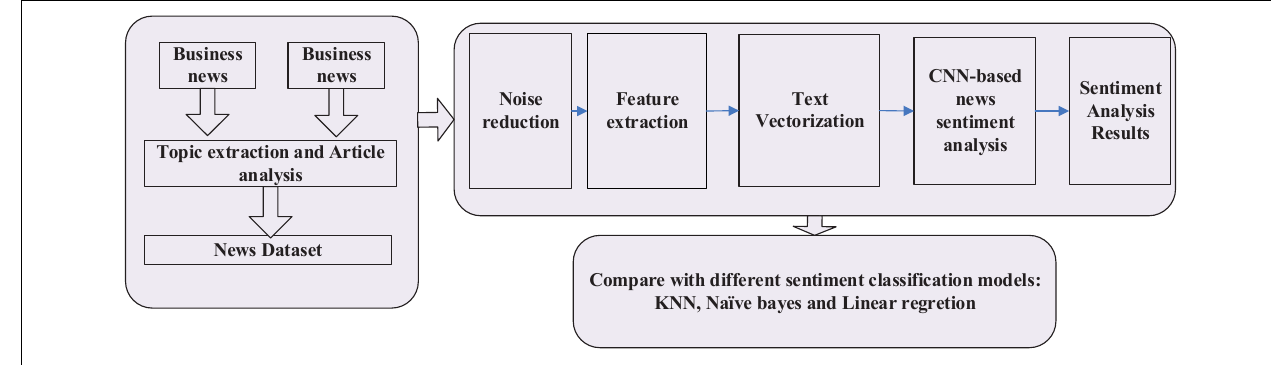
FIGURE 1 | The workflow of BuSeD for sentiment analysis and economic decision making.